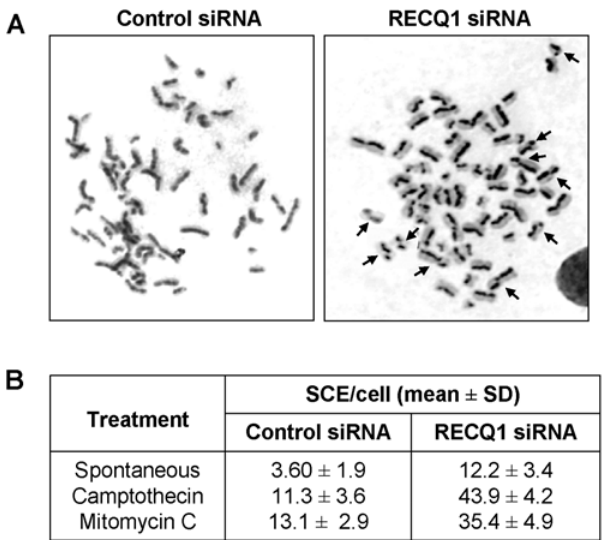
Figure 9. Elevated sister chromatid exchanges in RECQ1-depleted human cells. Panel A, SCEs were assayed in BrdU labeled, giemsa- stained chromosome spreads from control or RECQ1 siRNA treated HeLa cells. A representative spread is shown for spontaneous SCEs in control and RECQ1-depleted cells. Panel B , Quantitative representation of the number of SCEs per metaphase, either spontaneous or induced by CPT or MMC in cells treated with either control or RECQ1 siRNA. A minimum of 25 metaphases were counted for each cell type and treatment.